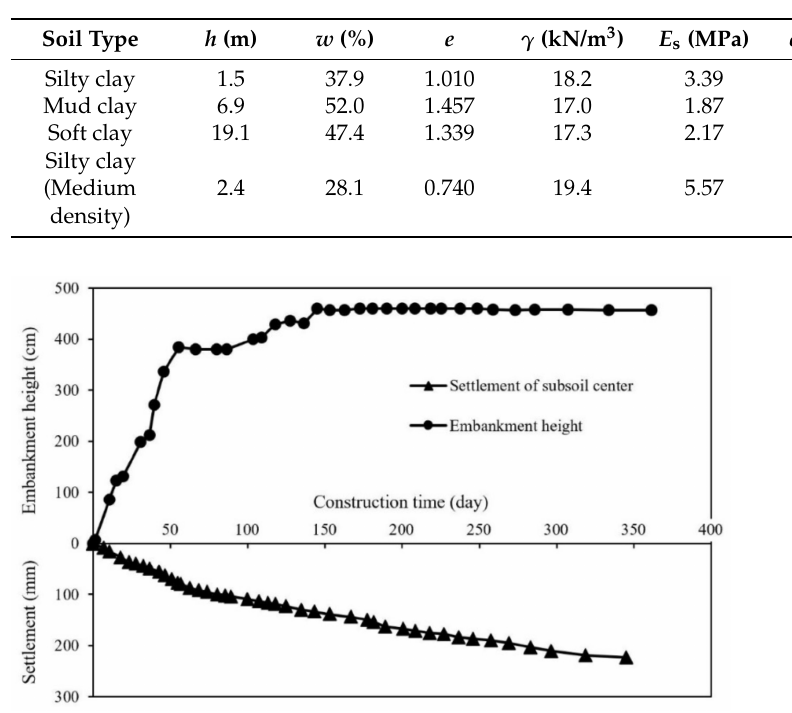
Figure 9. Embankment versus time curve and settlement versus time